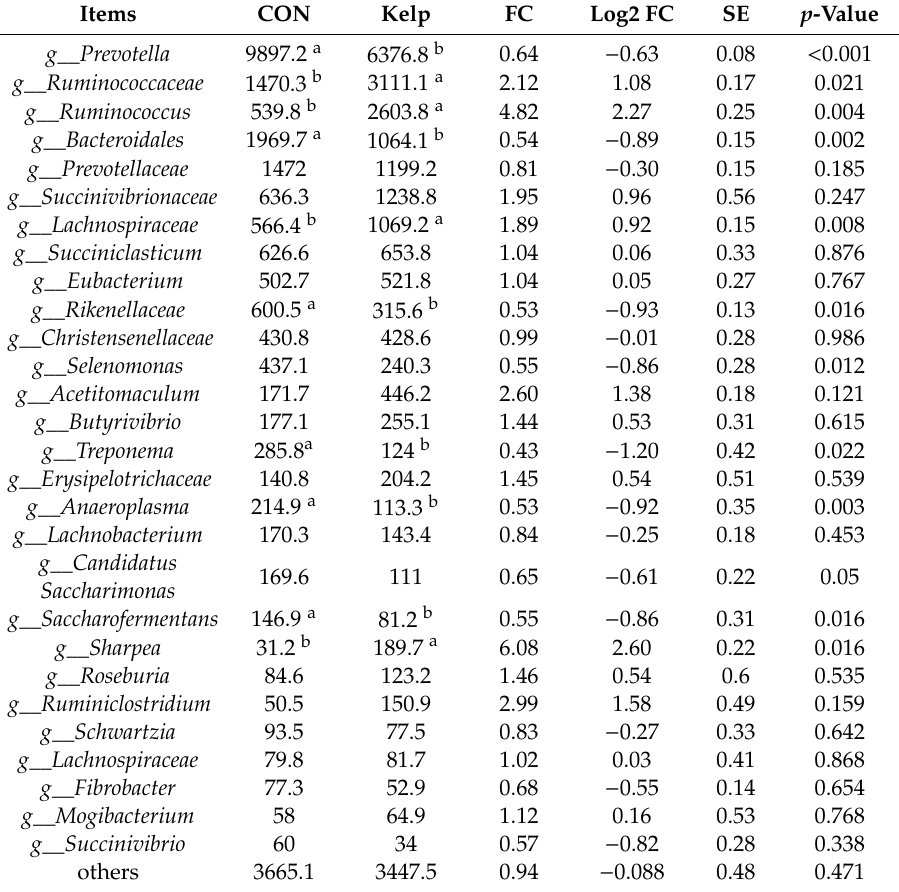
Table 5. E ff ects of kelp powder on the abundances of ruminal microbiota in genera